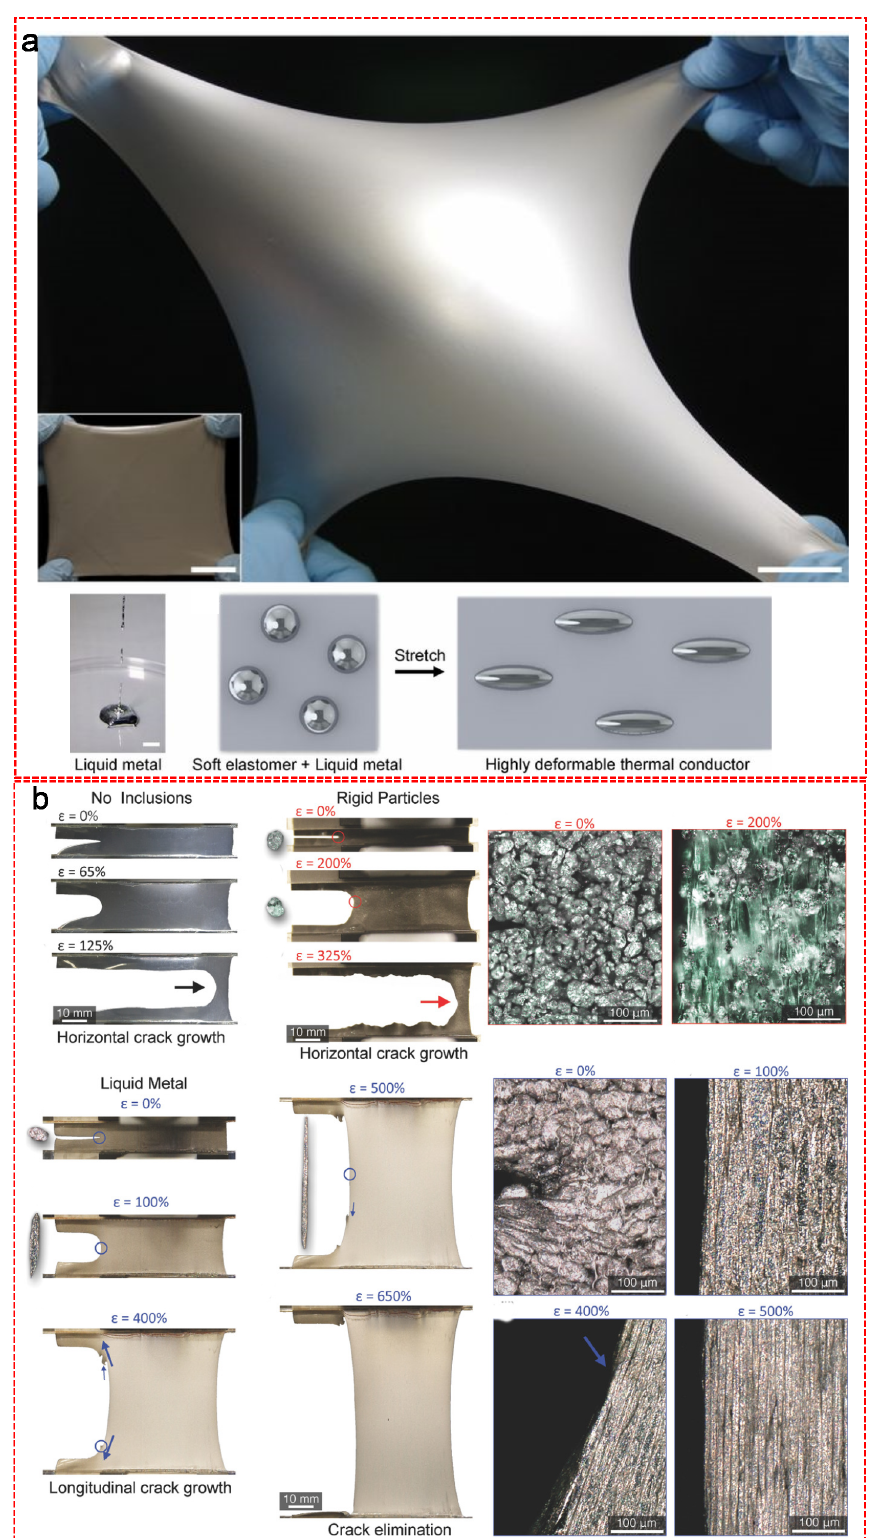
Figure 3. Synthesis of LM-polymer composites. ( a ) Highly deformable thermal conductor formed by LMEE. Reproduced with permission. [30] Copyright 2017, National Academy of Sciences. ( b ) Comparison of crack movement behavior among unfilled, rigid particles filled and LM filled polysiloxanes with different stretched states and their corresponding optical microscopy images. Reproduced with permission. [31] Copyright 2018, WILEY-VCH.